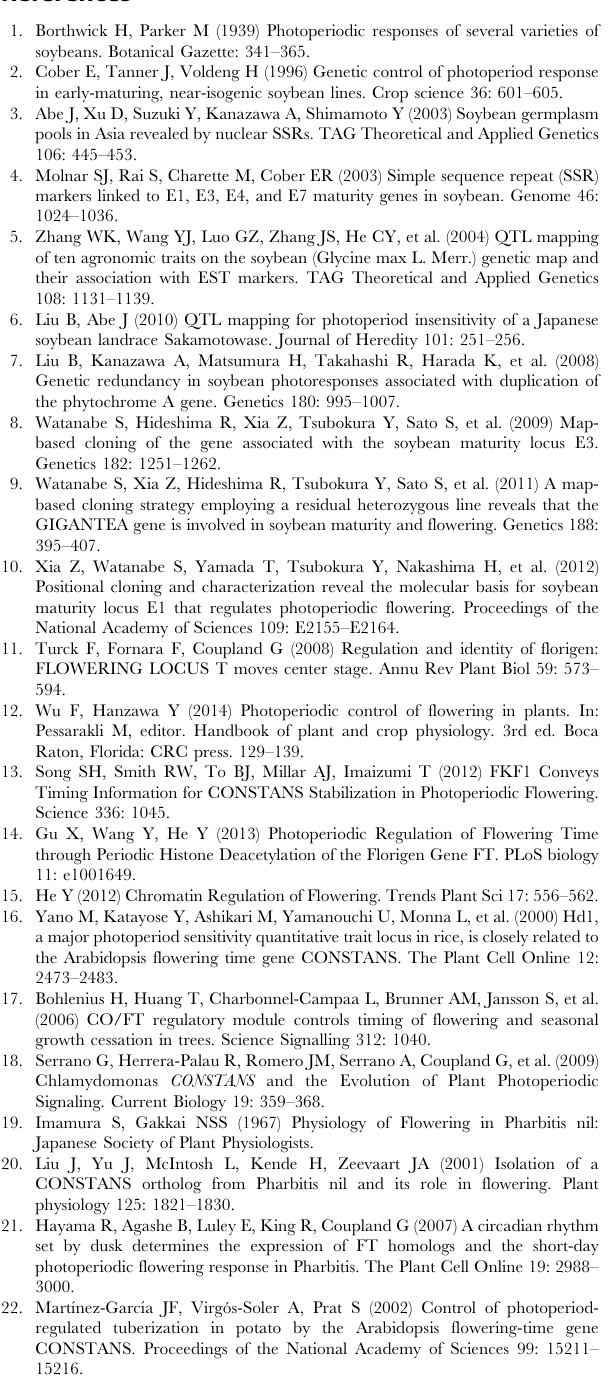
Table S1 Primers used for this